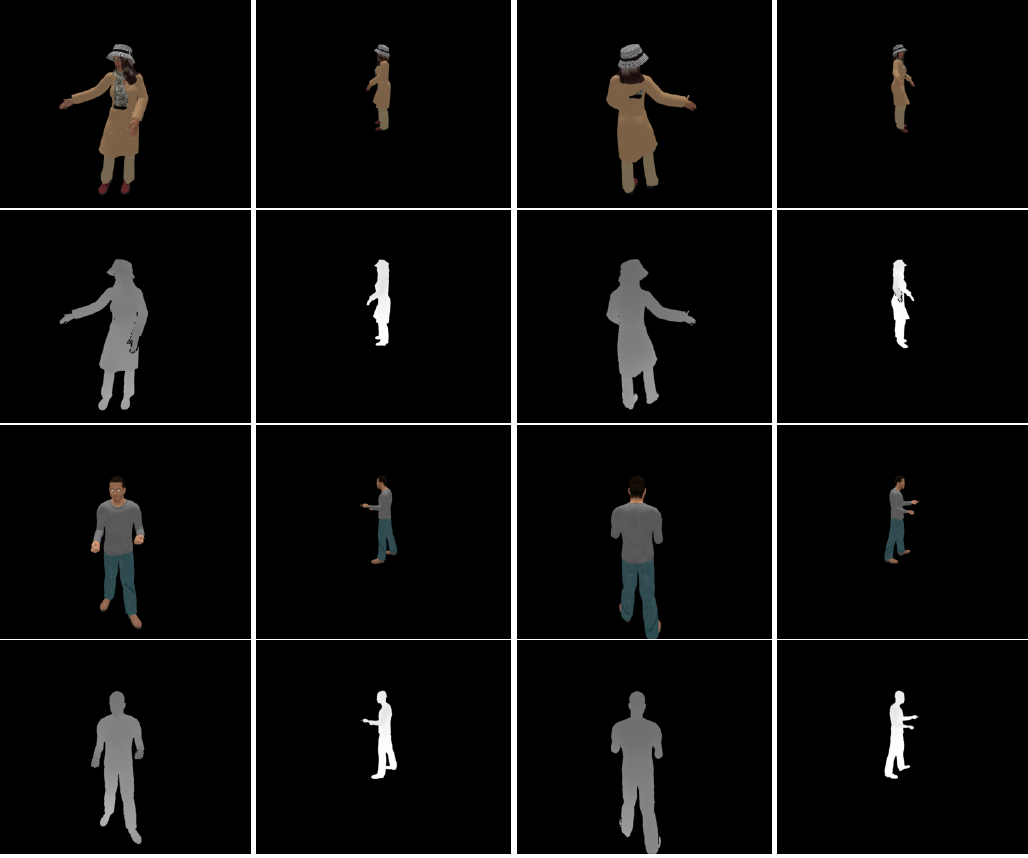
Figure 2. Sample RGB-D images in the synthetic dataset of Choi et al. [26]. ( First row ): Color images of the female model. ( Second row ): Depth images of the female model. ( Third row ): Color images of the male model. ( Fourth row ): Depth images of the male model. ( First column ): View 0. ( Second column ): View 3. ( Third column ): view 6. ( Fourth column ): View 9. The intensity of the depth images is linear with depth